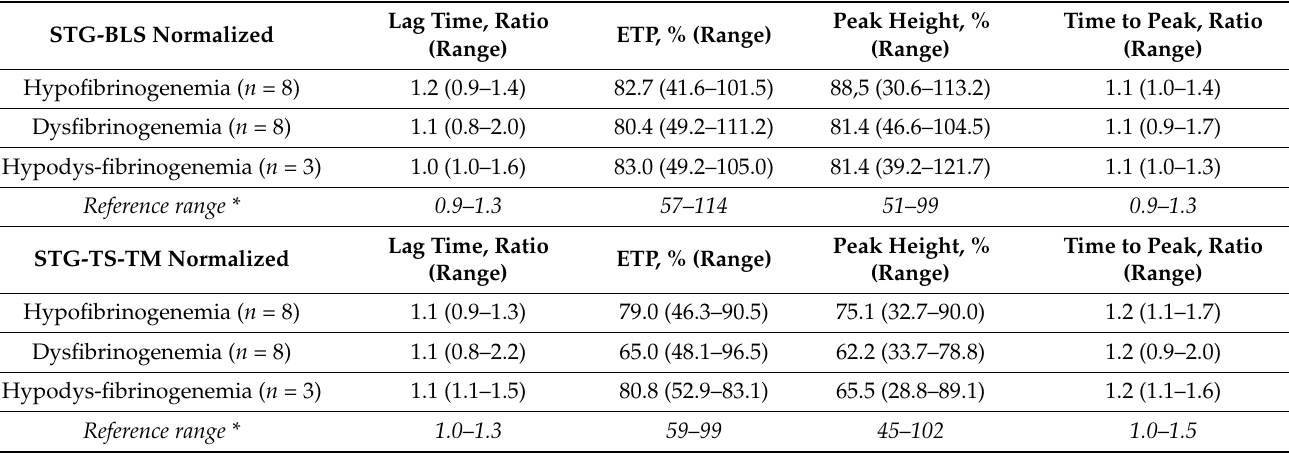
Table 2. Mean normalized TG variables with STG-BLS and STG-TS in the absence of thrombomodulin according to clinical and laboratory phenotypes.